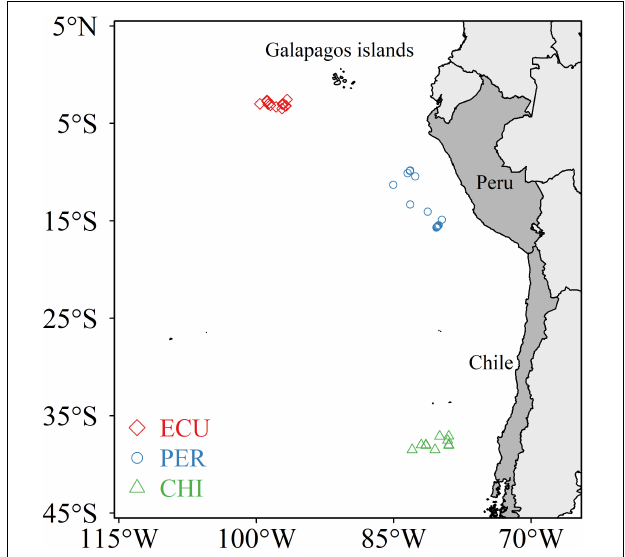
FIGURE 1 | Sampling locations of Dosidicus gigas from three areas in the southeastern Pacific Ocean: the waters off the Ecuadorian, Peruvian and Chilean Exclusive Economic Zone (ECU, PER, and CHI,